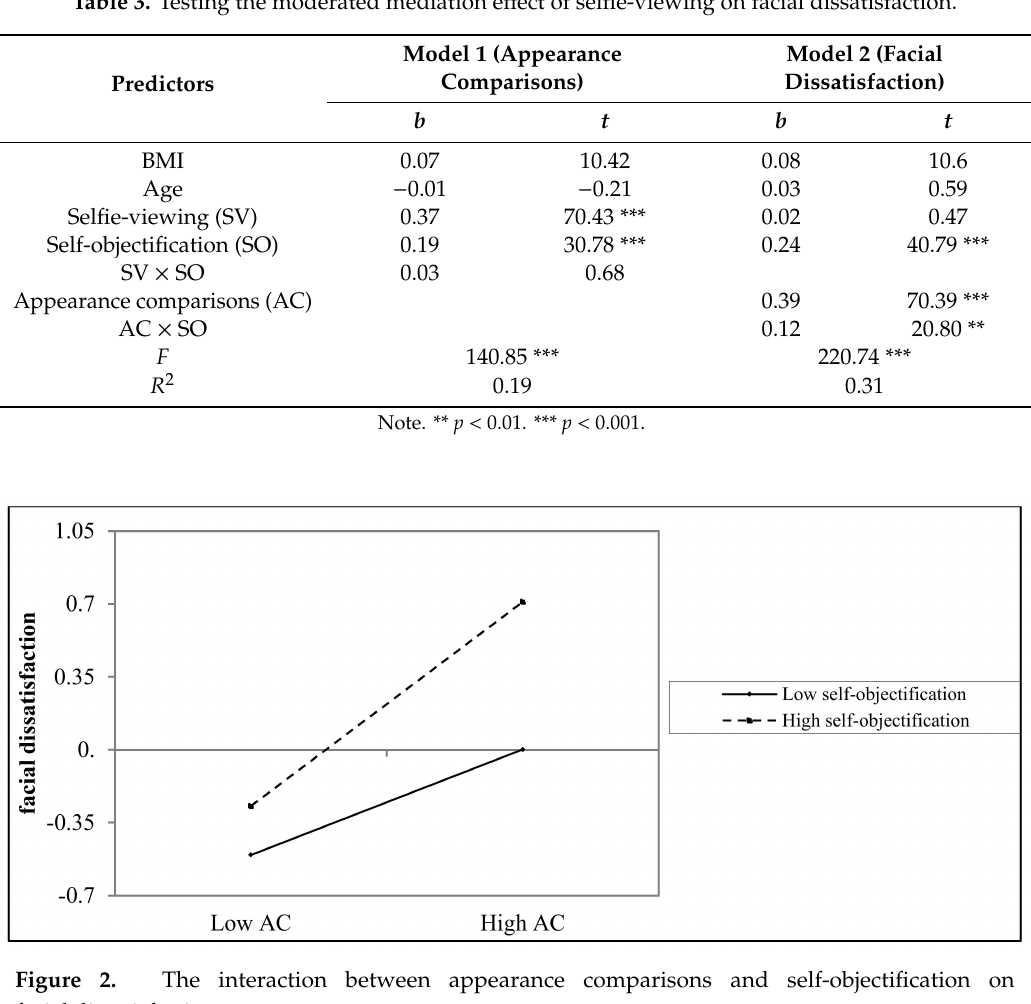
Table 3. Testing the moderated mediation e ff ect of selfie-viewing on facial dissatisfaction.